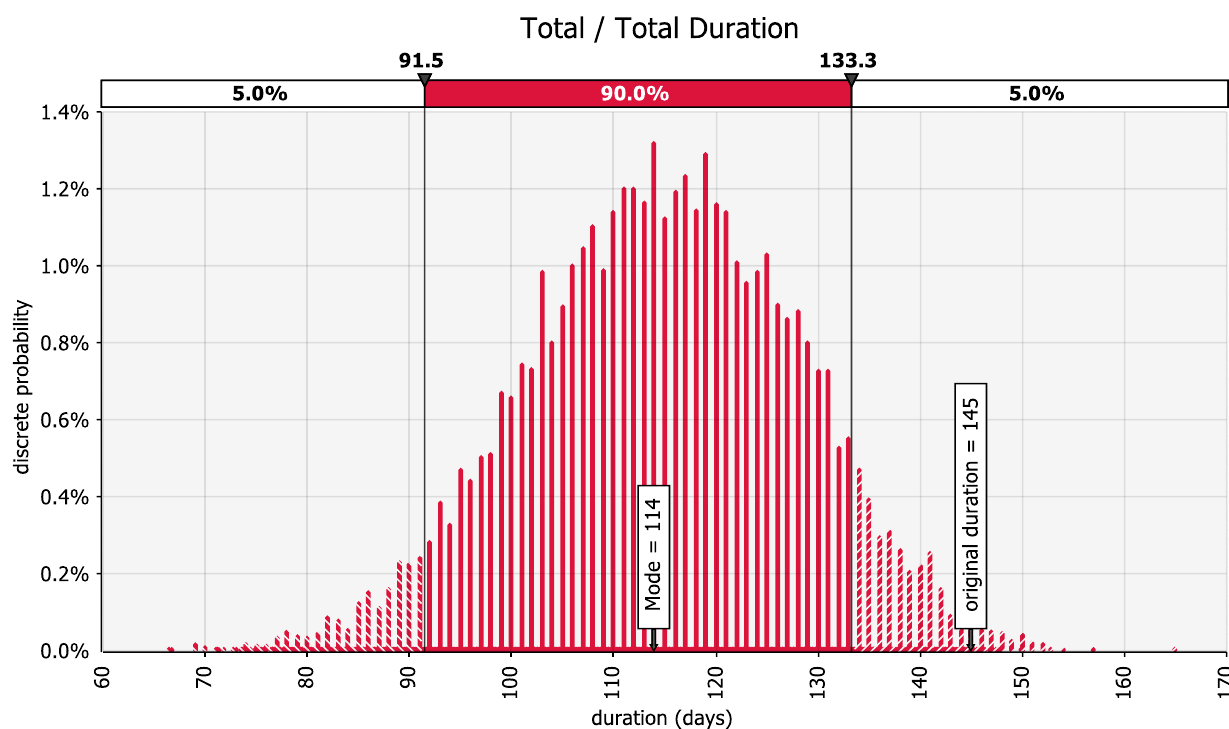
Figure 5. Total project duration (days) probability distribution. Source: [37].